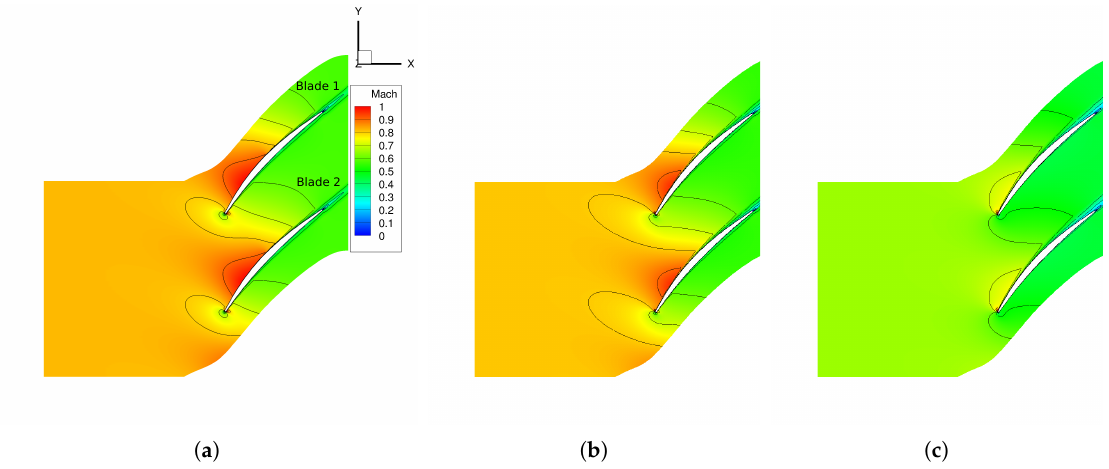
Figure 3. Mach number distribution for the reference blade section for all three operating conditions. ( a ) Cruise; ( b ) Takeoff; ( c ) Touchdown.